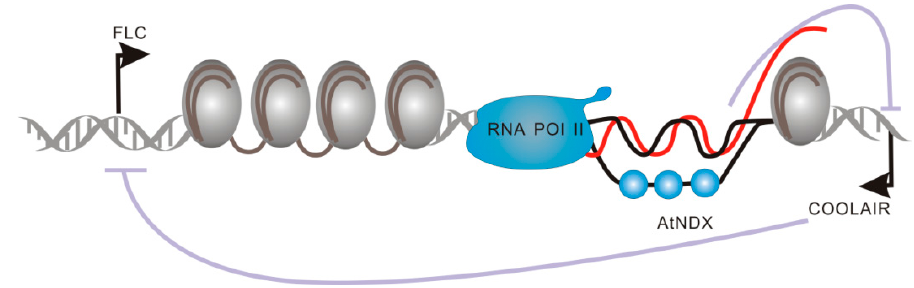
Figure 8. R-loop structures covering the COOLAIR promoter repress COOLAIR transcription. FLC : Flowering Locus C .